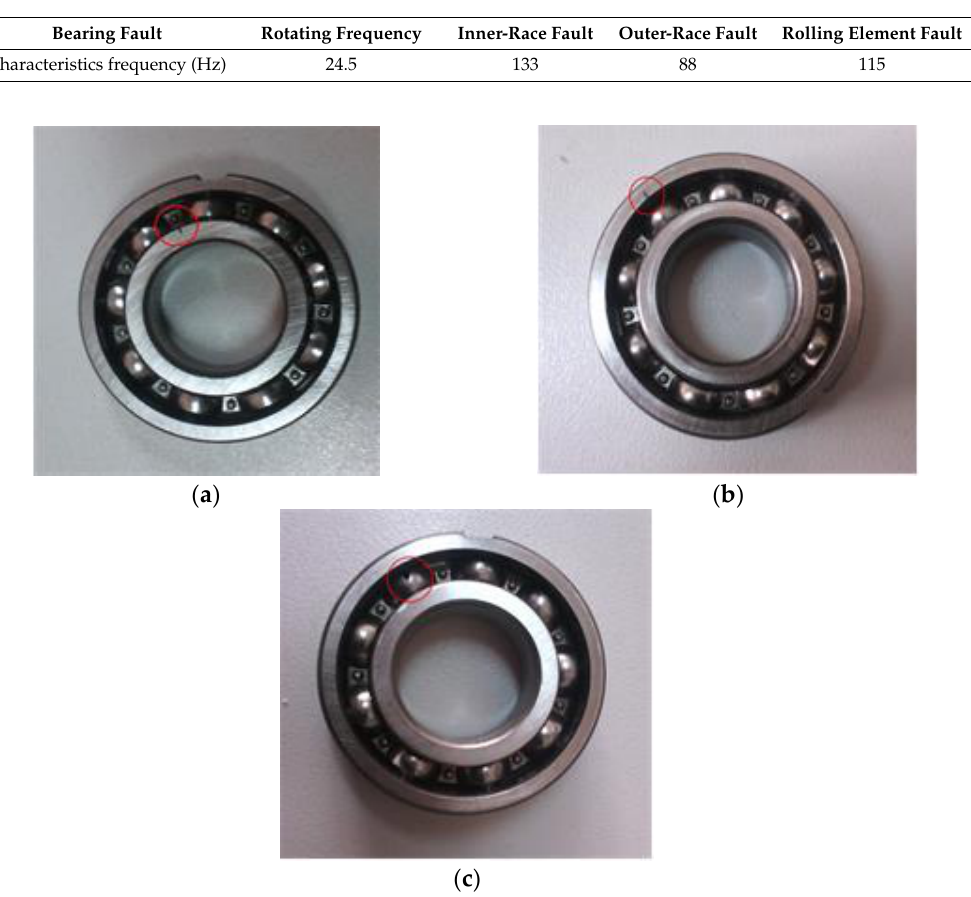
Table 2. The defect frequencies of deep groove ball bearing at 1470 rpm.